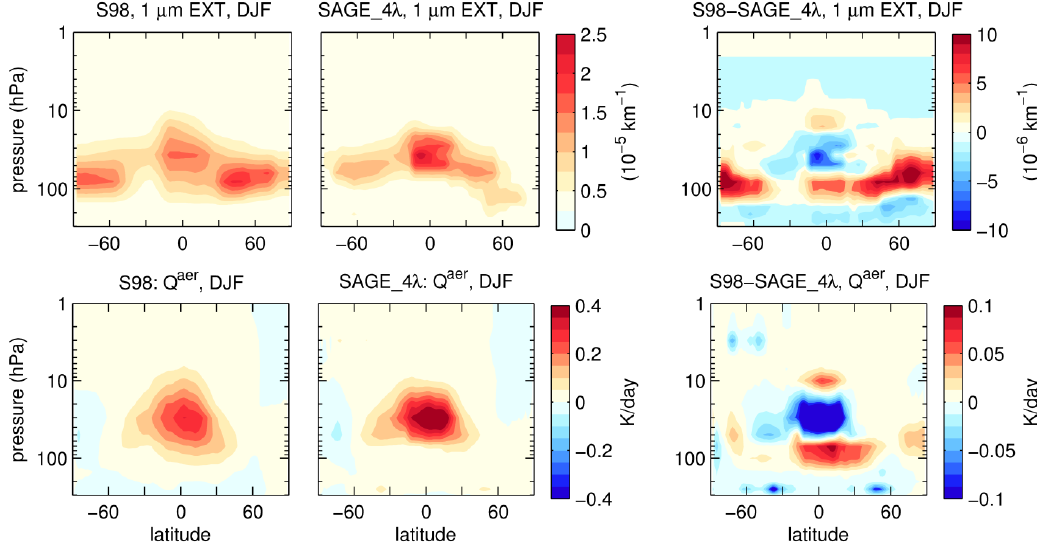
Figure 4. (top) Latitude–pressure distributions of 1µm aerosol extinction in the S98 and SAGE_4 λ volcanic aerosol forcing sets in first DJF Figure 4: (top) latitude-pressure distributions of 1 μm aerosol extinction in the S98 and SAGE_4λ 761 after Pinatubo (winter 1991/92). (bottom) Aerosol radiative heating ( Q aer ) as computed within the MPI-ESM model for each forcing set. volcanic aerosol forcing sets in first DJF after Pinatubo (winter 1991/92). (bottom) aerosol radiative 762 Right-hand column shows S98-SAGE_4 λ differences for both 1µm extinction and Q aer heating (Q aer ) as computed within the MPI-ESM model for each forcing set. Right-hand column shows 763 S98-SAGE_4λ differences for both 1 μm extinction and Q aer . 764 765